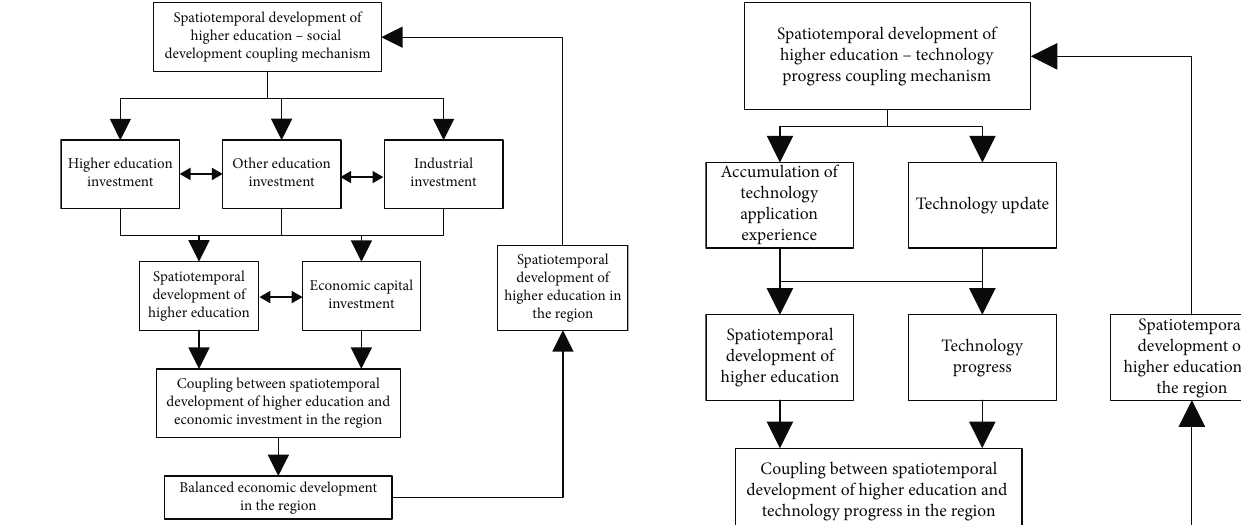
Figure 3: Principle of how social investment coupling mechanism affects regional economic